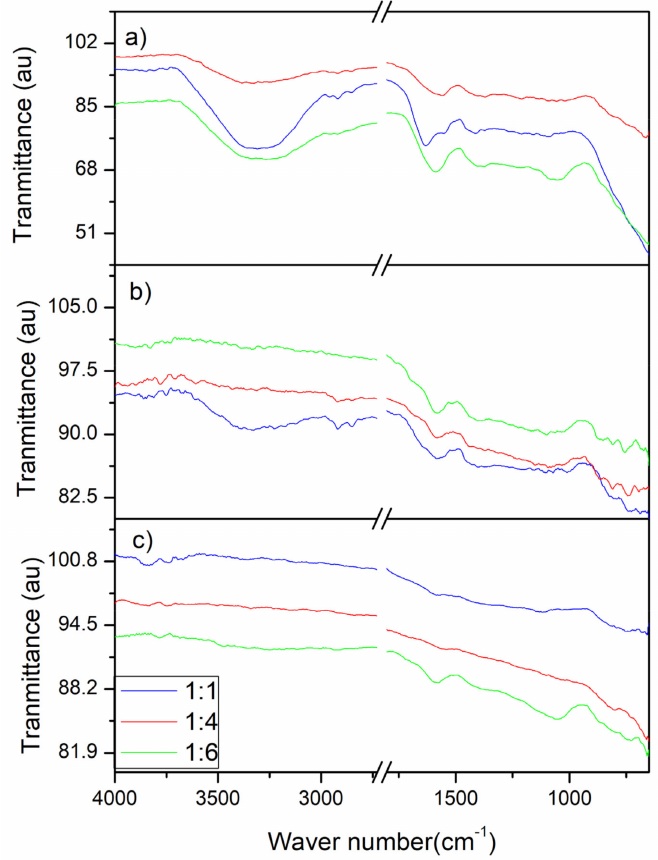
Figure 10. FT-IR spectra for solid phase products: ( a ) 673.15 K; ( b ) 713.15 K; ( c ) 773.15